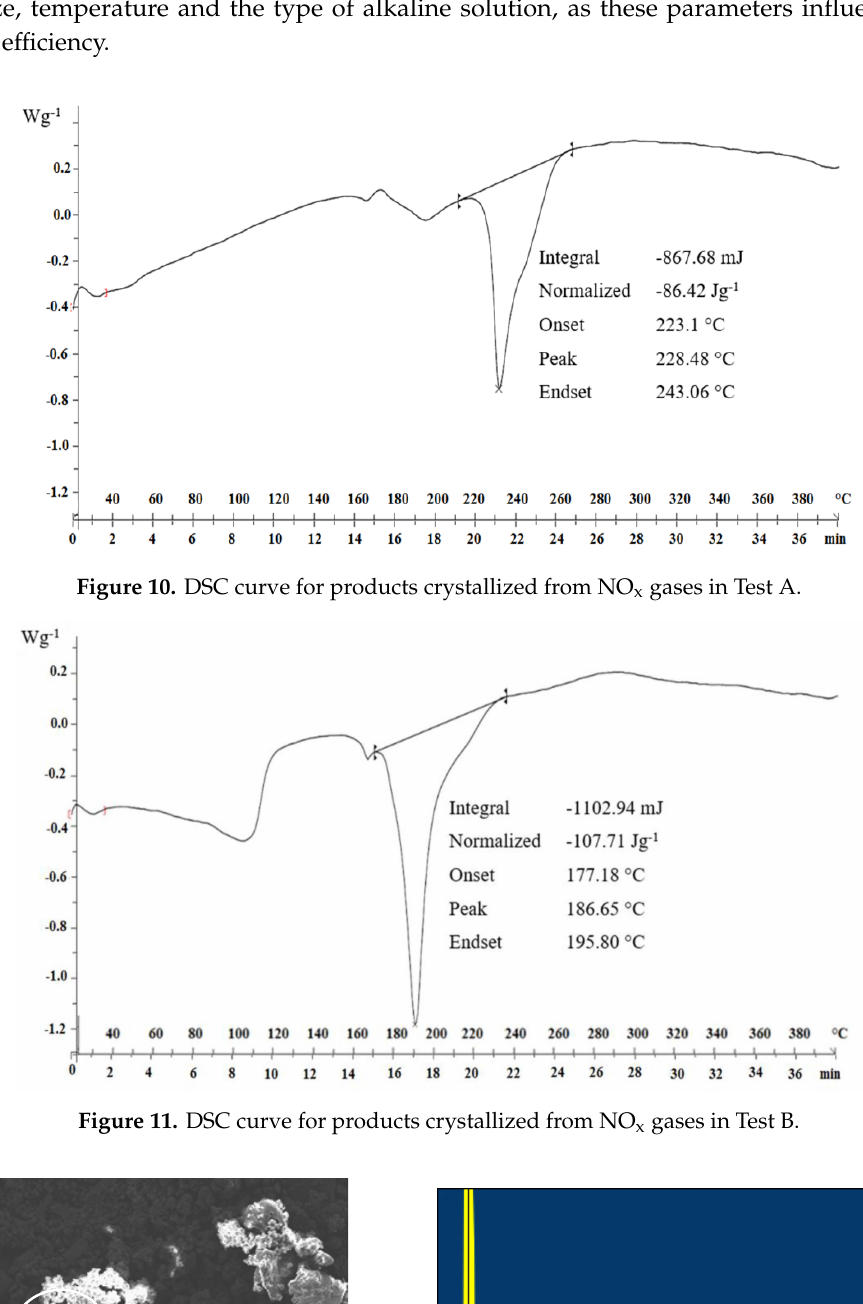
Figure 11. DSC curve for products crystallized from NO x gases in Test B.